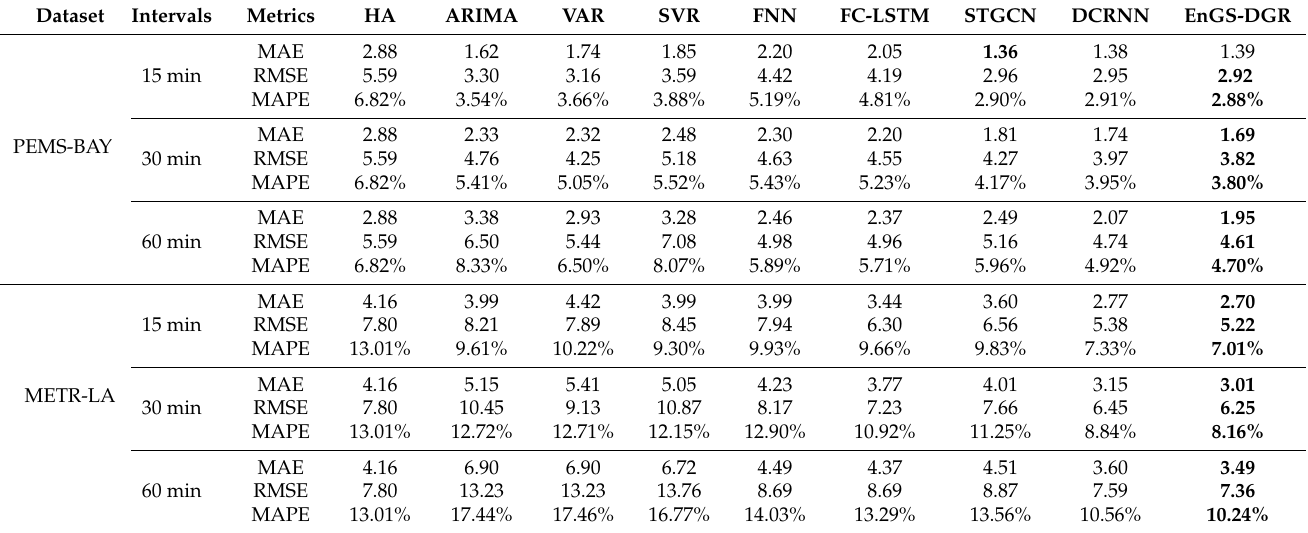
Table 1. The comparisons of evaluation indicators under different forecasting models.